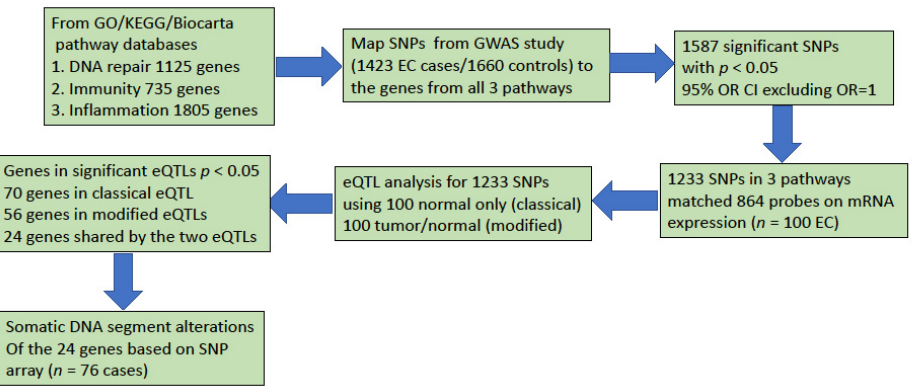
Figure 1. Flow chart for integrated analysis for classical and modified eQTL and somatic DNA segment alterations in immunity, DNA repair and inflammation in ESCC.